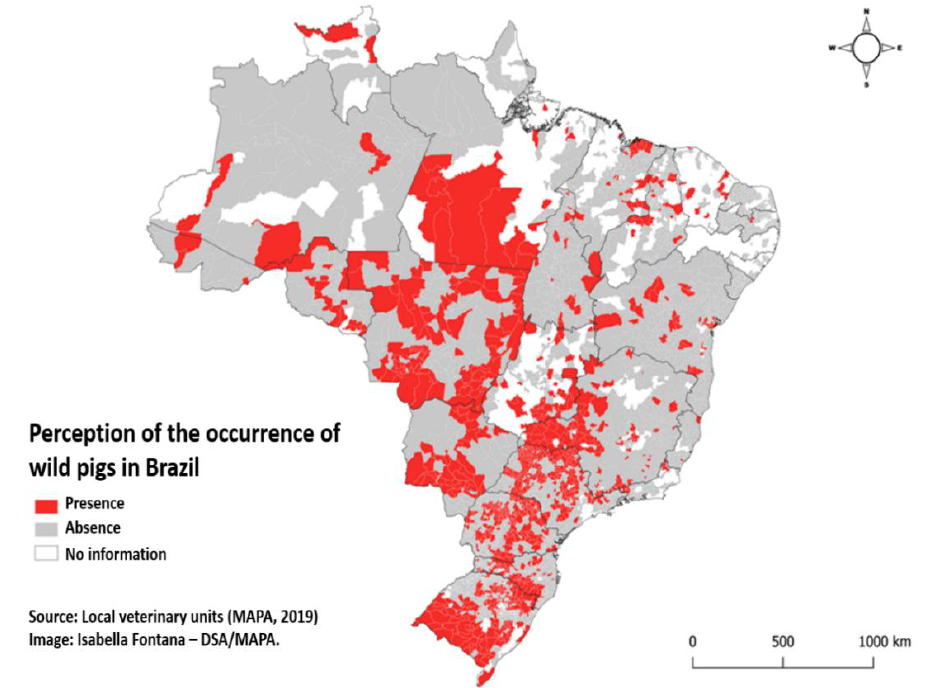
Figure 1. Perception of the occurrence of wild pigs in Brazil (Department of Animal Health of Ministry of Agriculture, Livestock, and Supply—Animal Health Defense Service (DSA)/Ministry of Agriculture, Livestock and Supply (MAPA), 2019 [13]).